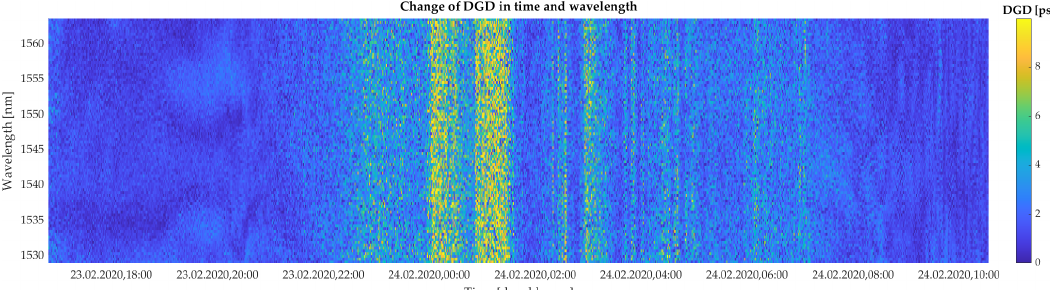
Figure 6. Colormap of the experimentally retrieved values of DGD as a function of 88 spectral channels in bandwidth ranging from 1528.97 nm to 1563 nm and selected time slots under a strong wind condition (wind speed up to 20